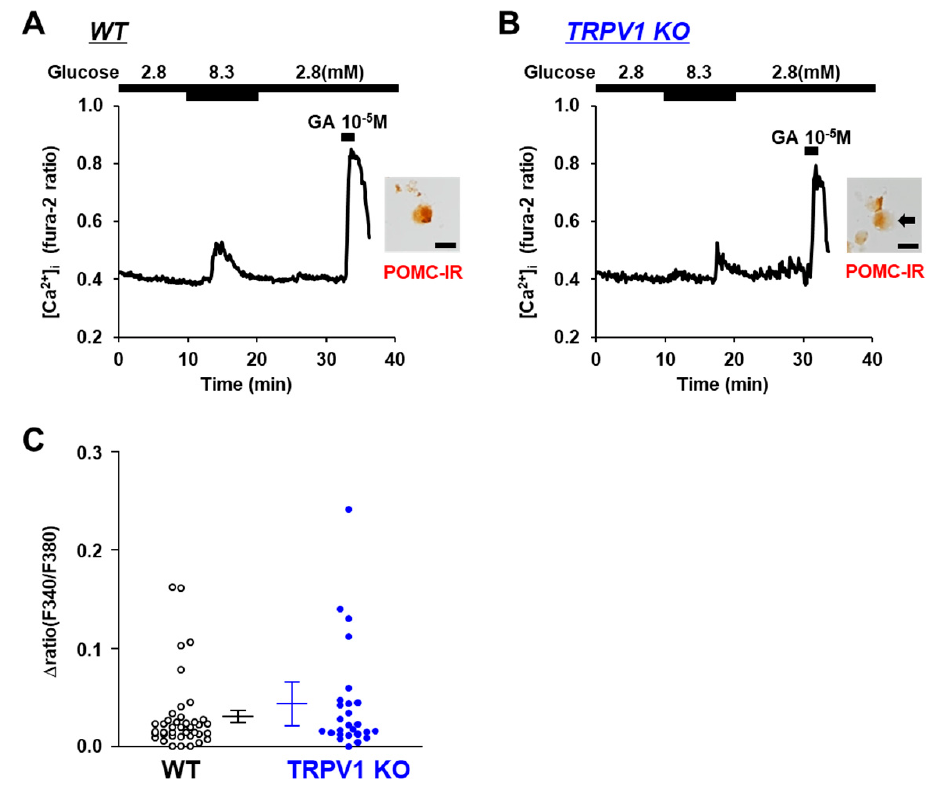
Figure 5. Glucose increased [Ca 2+ ] i in single POMC neurons. ( A , B ) Glucose (8.3 mM) increased [Ca 2+ ] i in POMC neurons from wild-type (WT) mice ( A ) and Trpv1 KO mice ( B ). Scale bar is 20 μ m. ( C ) Average amplitude of [Ca 2+ ] i responses ( Δ ratio) in POMC neurons. Data are presented as mean ± SEM. WT vs. KO determined by one-way ANOVA followed by the Bonferroni test.